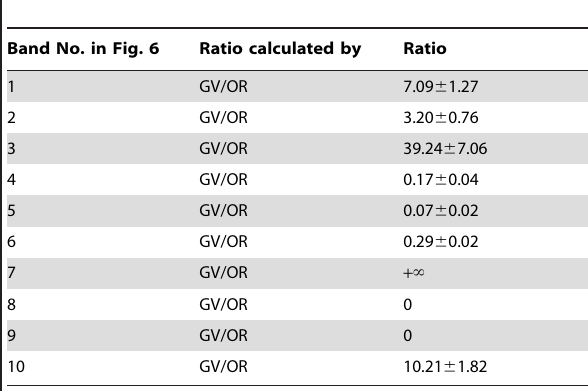
Table 2. Quantitative comparison of the ten most upregulated proteins in GV and OR